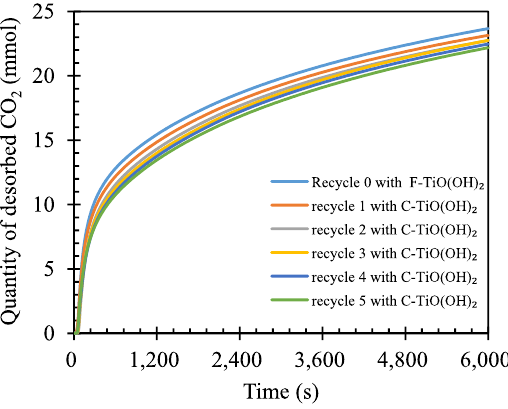
Figure 5. Cyclic performance of TiO(OH) 2 on NaHCO 3 decomposition [initial NaHCO 3 concentration: 0.238 mol/L; Ti/Na molar ratio: 0.78, stirring rate: 600 rpm; reaction temperature: 60 °C, N 2 flow rate: 500 mL/ min].